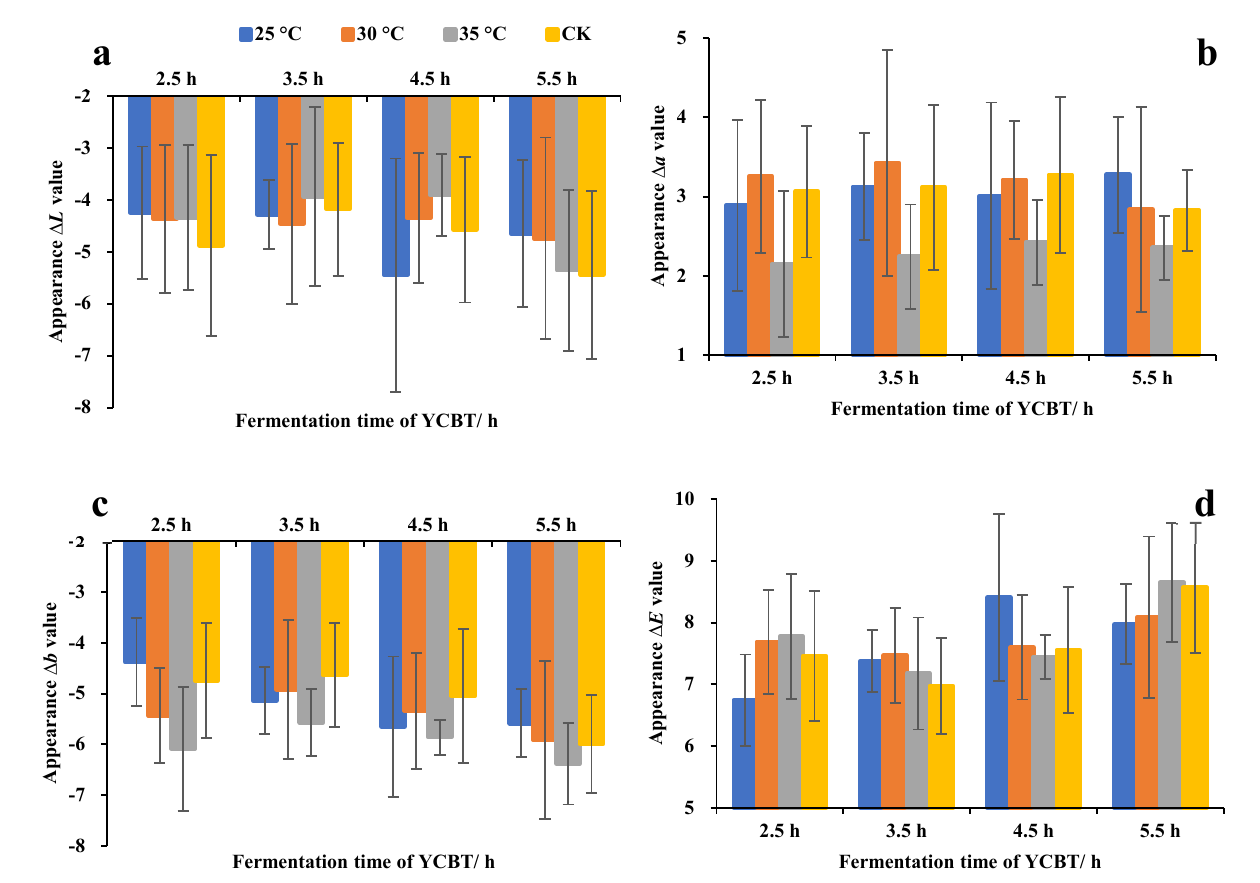
Figure 2. Effect of the fermentation temperature and time on the appearance color of Yunnan Congou black tea (YCBT) fermentation: ( a ) difference in the L value between rolled and fermenting leaves, ( b ) difference in the a value between rolled and fermenting leaves, ( c ) difference in the b value between rolled and fermenting leaves, and ( d ) difference in the total chromatic aberration value between rolled and fermenting